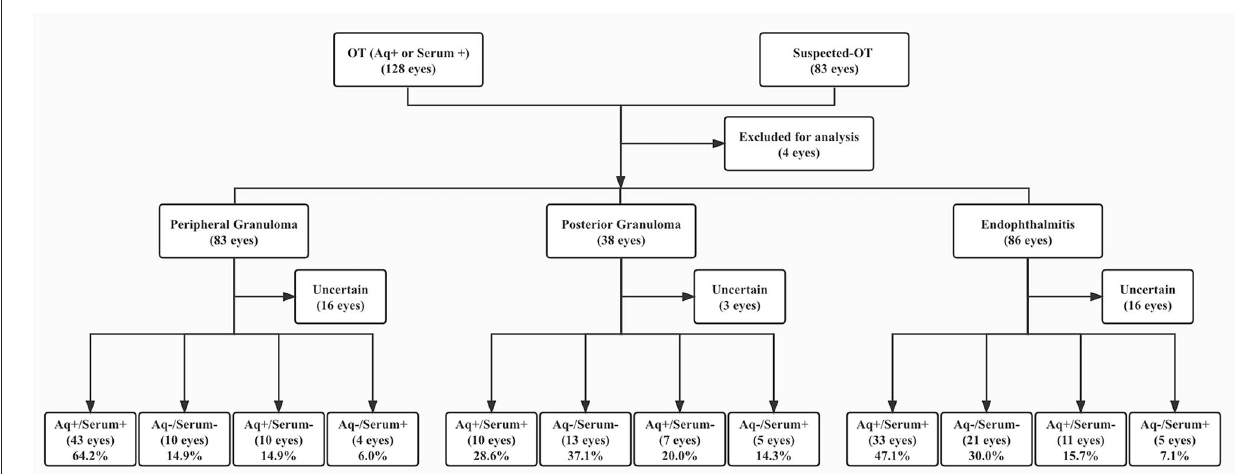
FIGURE 2 | Patient groups according to clinical features and aqueous and serum T-IgG status. T-IgG status referred to positive, negative, or uncertain of the anti- T. canis antibody in samples. + referred to T-IgG positive, – referred to T-IgG negative. OT, ocular toxocariasis; Aq, aqueous. Patients whose samples were not measured or with uncertain values (for serum samples) were put in the Uncertain group.